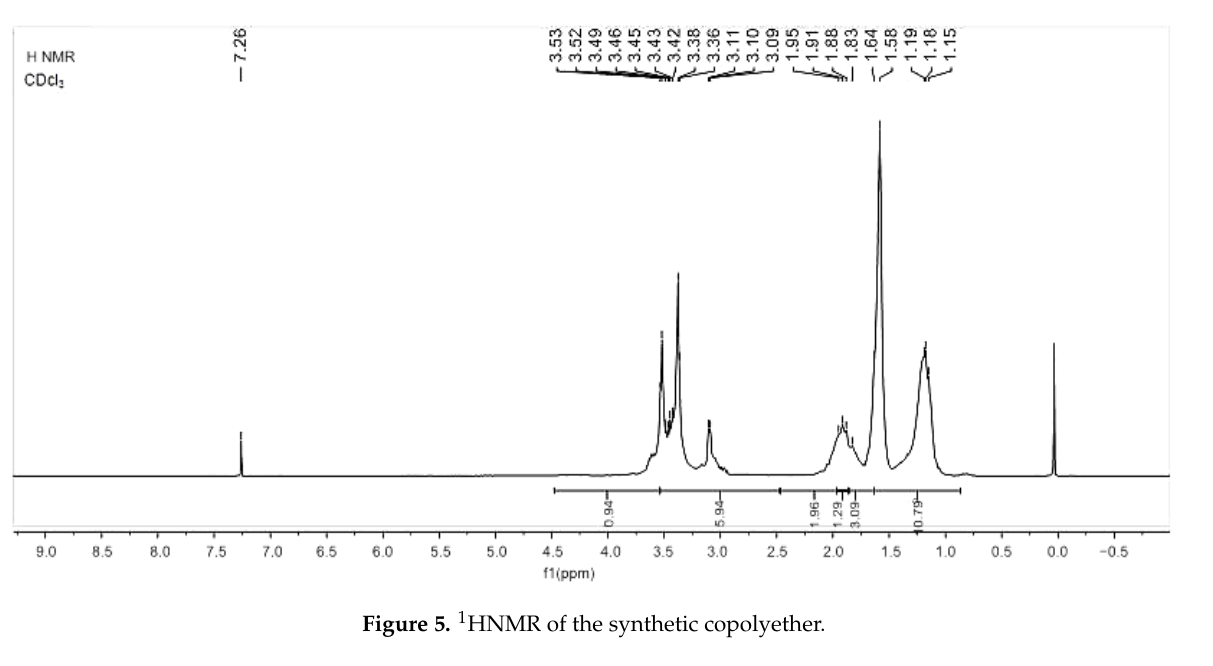
the residual monomers. Both the IR and 1 HNMR spectrum suggested hydroxyl terminated Figure 4. Structure analysis of the synthetic copolyether.